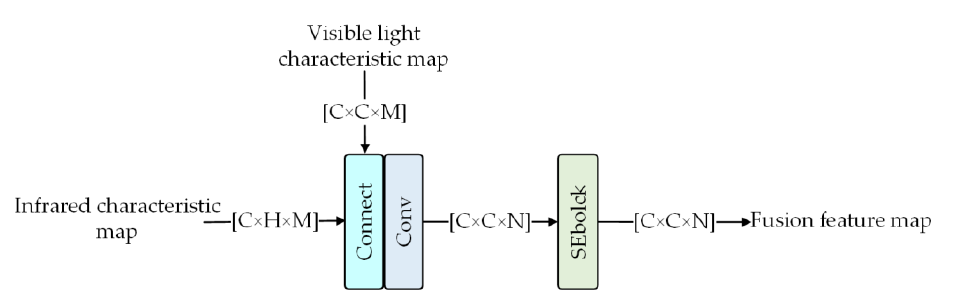
Figure 4. Feature fusion module.